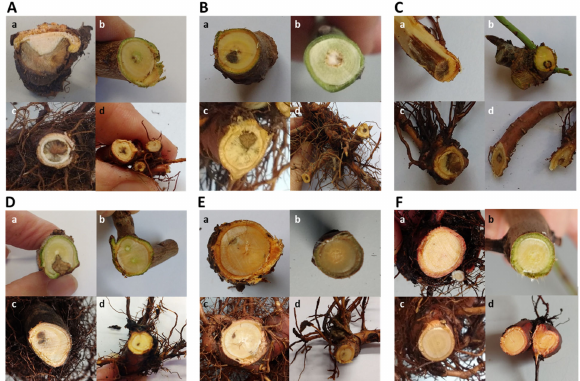
Figure 4. Representative internal symptoms in ‘Lauranne’ almonds grafted onto ‘GxN-15’ inoculated with ( A ) Ilyonectria liriodendri AL79 isolate; ( B ) Neonectria quercicola AL141 isolate; ( C ) Neonectria sp. 1 AL77 isolate; ( D ) Dactylonectria novozelandica AL84 isolate; ( E ) D. torresensis AL29 isolate; ( F ) non- inoculated control plants. Symptoms in inoculated plants consisted of sectorized necrosis in basal stem ( a ); slight or no symptoms in the grafted variety ( b ); central or sectorized necrosis in the main root ( c ) and secondary roots ( d